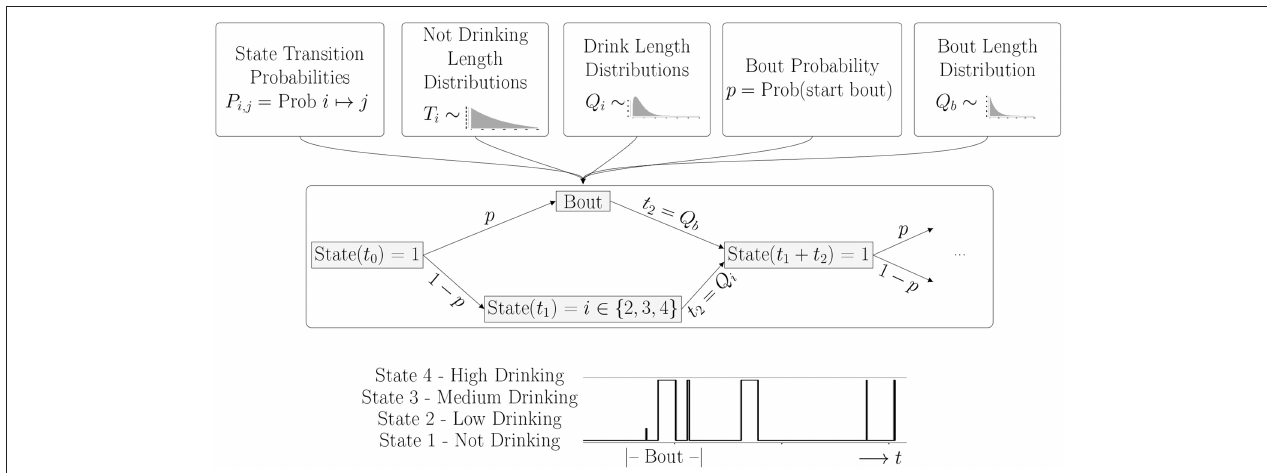
FIGURE 1 | Overview of Model: Once all parameters for the probability distributions are estimated from the data, the simulation is run for an individual monkey. The probabilities determine if the monkey is in a bout or not, and the drinking state. The distributions determine how long the monkey stays in each state. The bottom panel shows a short piece of a time series generated by a typical simulation. A Bout is defined as a sequence of drinks where the intervals between drinks is less than 300 s. In this simulation, we see a bout consisting of one drink with a low drinking rate, followed by two drinks at a high rate, and then three single drinks of varying lengths at a high drinking rate.